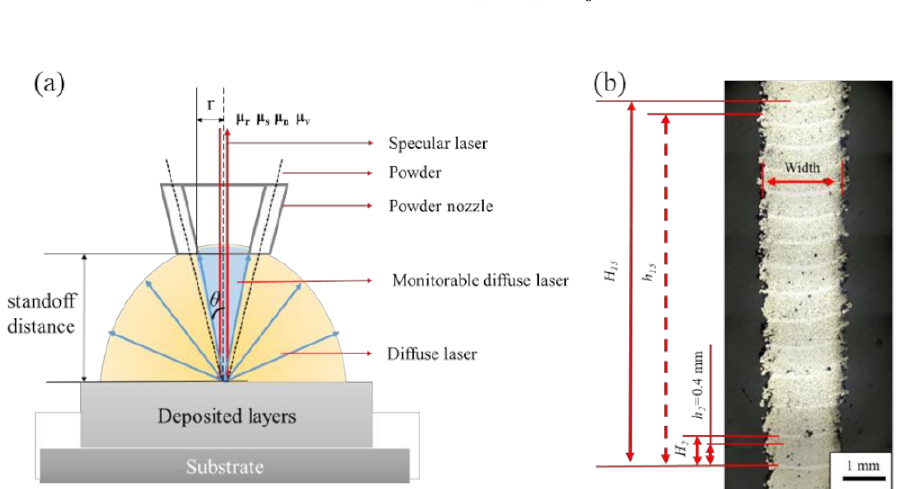
Figure 11. Schematic diagram of reflected laser: ( a ) the positions of standoff distance, light source, surface normal, reflected, and viewing vectors; ( b ) OM image of the 2nd to 15th layers of the aluminum alloy sample in cross-section, in which location the layer thickness changes most